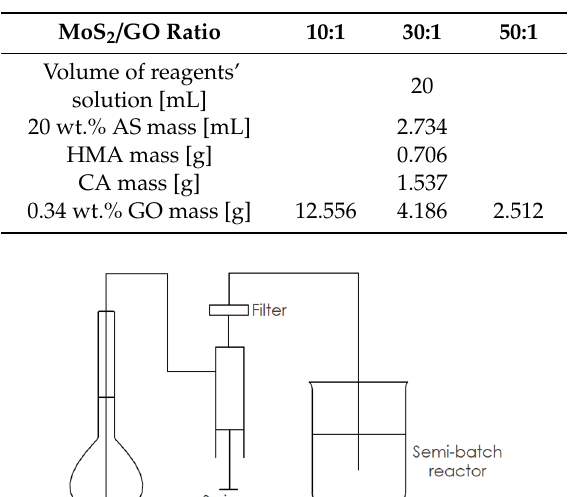
Table 1. The weight of reagents used. HMA: ammonium heptamolybdate tetrahydrate; AS: ammonium sulfide; CA: Citric acid.